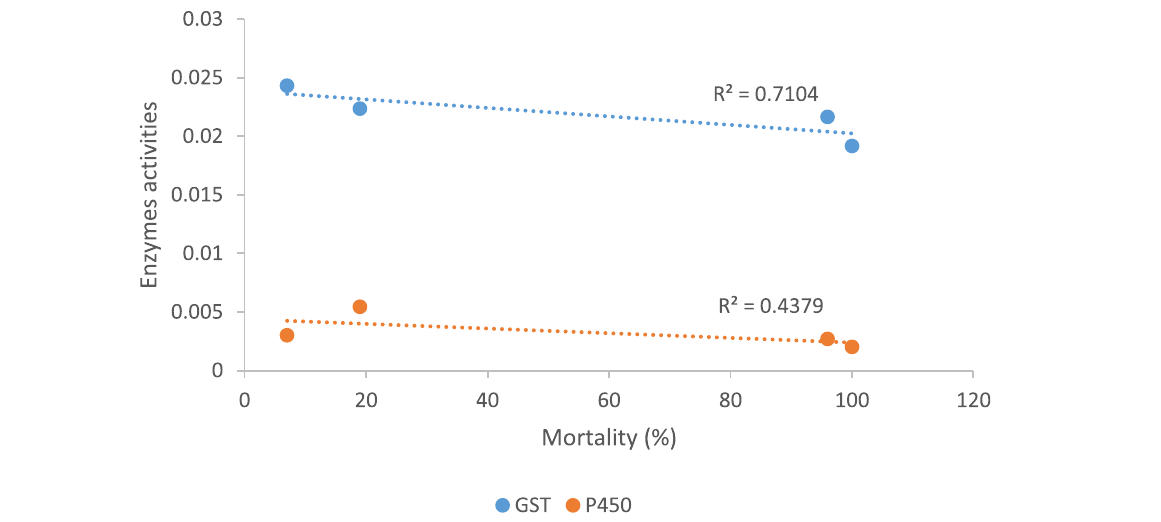
Fig. 2 Regression of mortality rate of Aedes aegypti exposed to DDT and mean level enzymes activity in four LGAs from Lagos state,